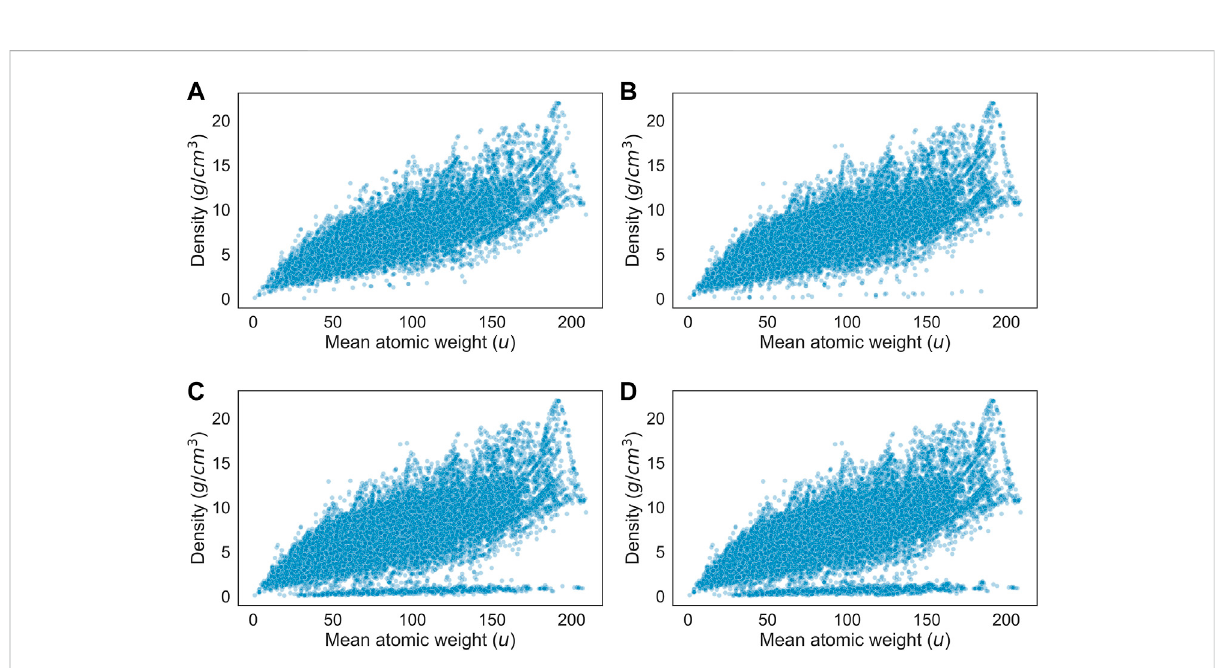
FIGURE 5 Scatterplot of density (g/cm 3 ) versus mean atomic weight ( u ) for all crystals with an energy above hull below (A) 0.05 eV/atom (B) 0.5 eV/atom (C) 2.5 eV/atom (D) no limit.